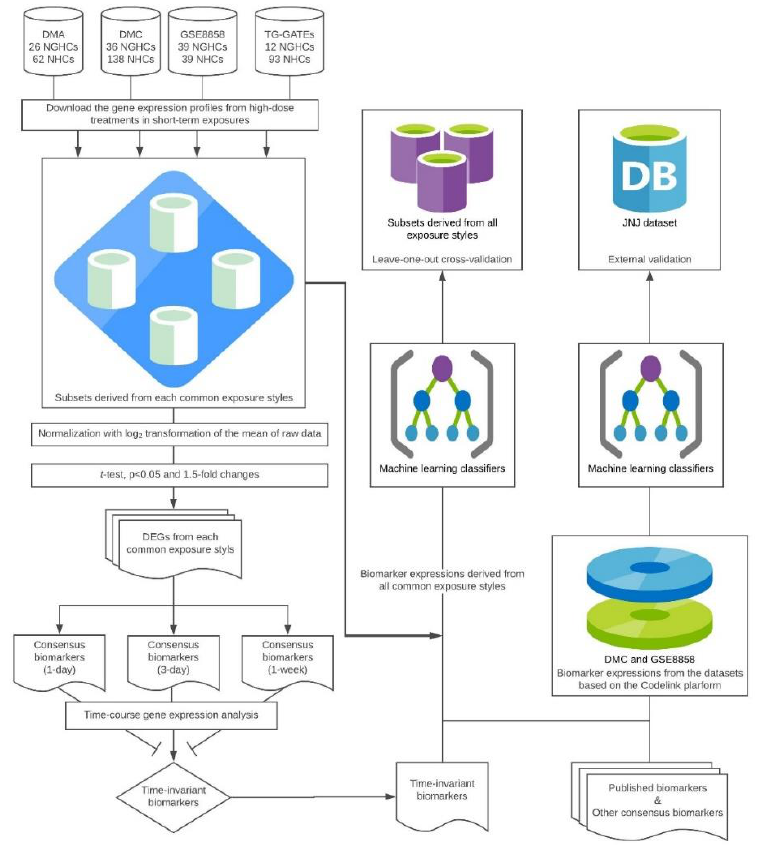
Figure 1. System flow. Abbreviations: DMA, Drug Matrix with Affymetrix platform; DMC, DrugMatrix with Codelink platform; DEGs, differential expression genes. * Consensus biomarkers (3 days) were identified as the time-invariant biomarkers; GSE8858, Gene Expression Omnibus accession no. 8858; TG-GATEs, Toxicogenomics Project-Genomics Assisted Toxicity Evaluation System; JNJ dataset, Johnson and Johnson dataset; NGHC, non-genotoxic hepatocarcinogens; NHC, non-hepatocarcinogens.